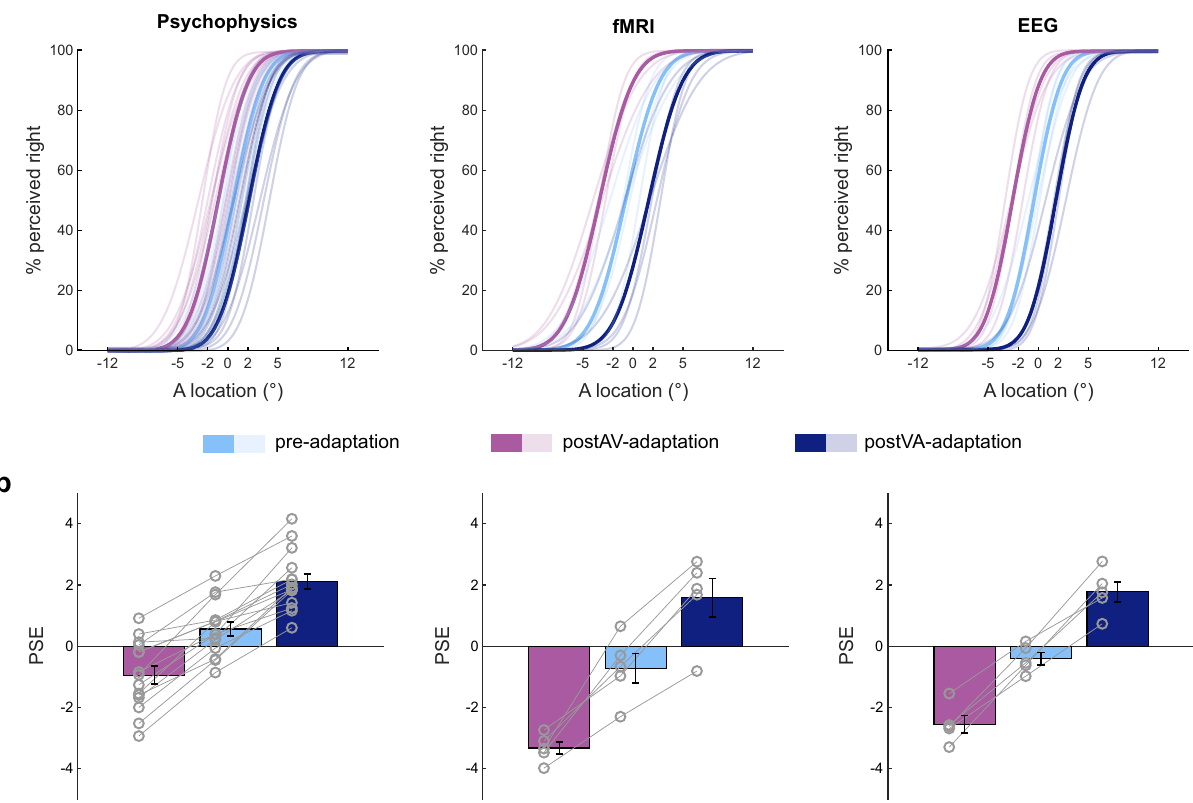
Fig. 2 Behavioural results. a Psychometric functions fi tted to the behavioural data from the psychophysics, fMRI and EEG experiments for pre-, postAV- and postVA-adaptation phases (semi-transparent lines represent subject-speci fi c psychometric functions, solid lines represent across-subjects ’ mean). b Across-subjects ’ mean (±SEM, n = 15 subjects for psychophysics, n = 5 subjects for fMRI and EEG) of the PSE for pre-adaptation, postVA- and postAV- adaptation phases. The subject-speci fi c PSEs are overlaid as line graphs with circular markers. The PSE was shifted towards the left for postAV- (purple) relative to postVA-adaptation (dark blue) phases in every single participant. PSE point of subjective equality, SEM standard error of the mean. Source data are provided as a Source Data fi